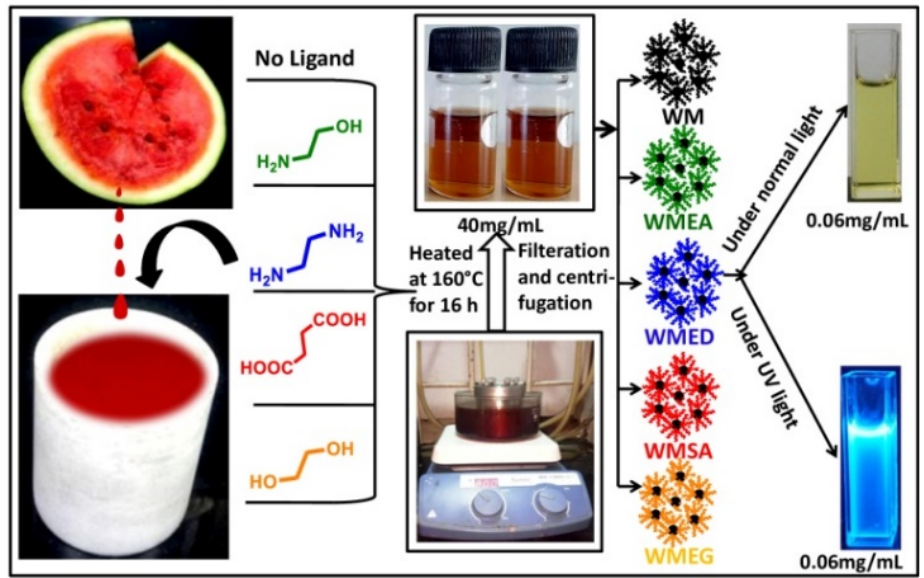
Scheme 1. Graphical representation of the one-pot synthesis of CQDs from watermelon juice by adding different surface passivating